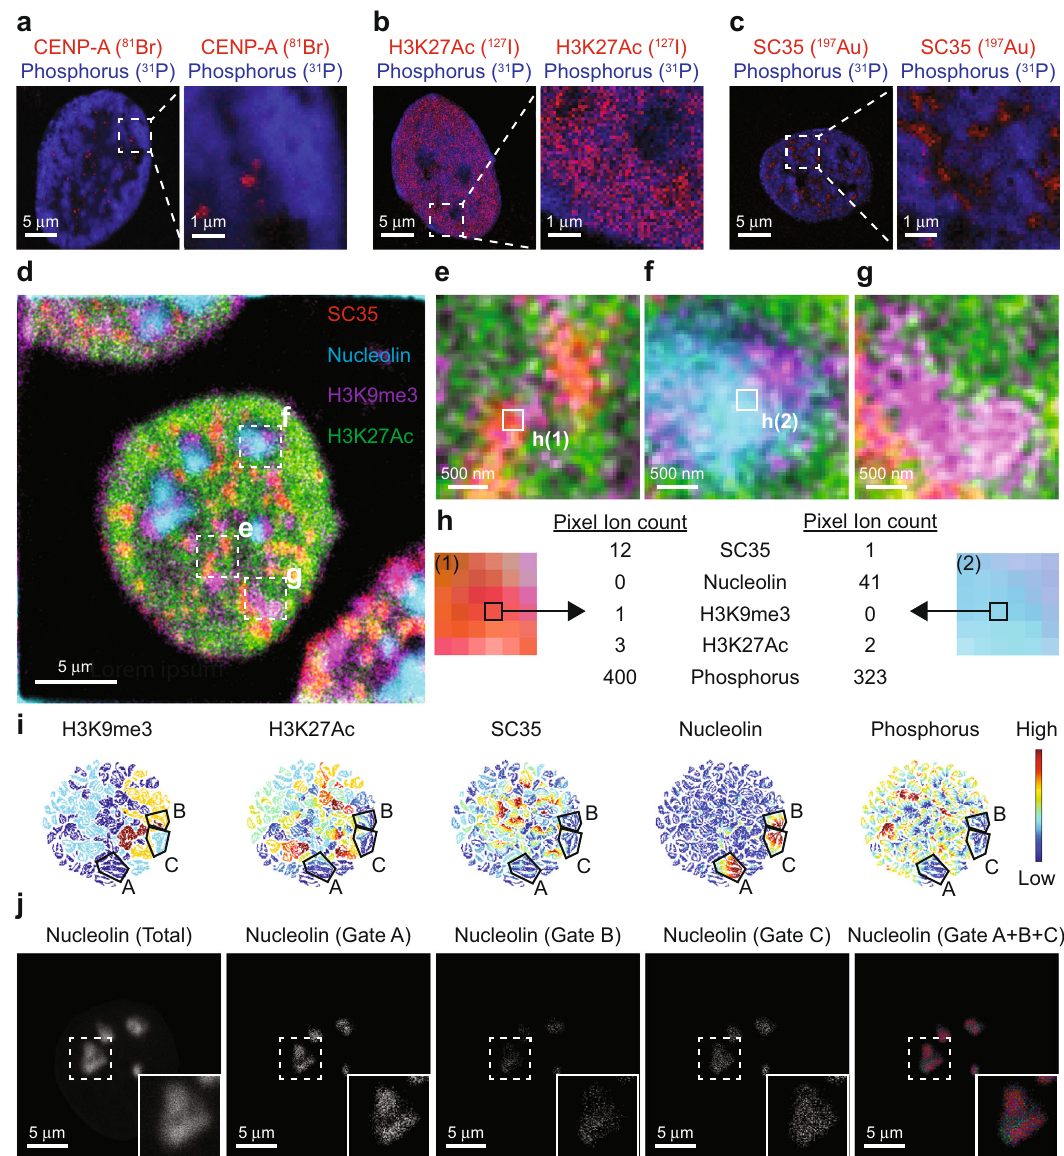
Fig. 2 Multiparametric HD-MIBI using MoC-Abs identi fi es unique subcellular features. a – c (Left) Representative HD-MIBI images of a HeLa cell stained with a anti-CENP-A- 81 Br/Cy3, b anti-H3K27Ac- 127 Ir/Cy5, and c anti-SC35-biotin recognized by streptavidin- 197 Au/FITC. Overlay of ion images for MoC- Ab (red) and phosphorus ( 31 P; blue). (Right) A digital zoom of boxed area in the original image to show speci fi city of MoC-Ab signal. All images consist of the sums of 10 consecutive planes. n = 3. d Composite HD-MIBI image of nucleolin (cyan), H3K9me3 (magenta), H3K27Ac (green), and SC35 (red) in a HeLa cell. Cells were stained with anti-nucleolin- 19 F/FITC, anti-H3K9me3- 81 Br/Cy3, anti-H3K27Ac- 127 Ir/Cy5, and anti-SC35-biotin (recognized by streptavidin- 197 Au/FITC). The image consists of the sum of 10 consecutive planes. n = 3. e – g Multiple enlarged images from boxed regions in panel ( d ) showing e a nuclear speckle, f a nucleolus, and g heterochromatin. h The largest nucleus in panel ( d ) was masked using the phosphorus signal. The ion counts for each acquired marker (nucleolin, 19 F; DNA, 31 P; H3K9me3, 81 Br; H3K27Ac, 127 I; and SC35, 197 Au) were extracted. i t-SNE maps of the nucleus in the center of the image shown in panel ( d ) were created using the ion counts for each of the 84,836 pixels from the mask described in ( h ). The ion count for each marker in each pixel was min – max normalized to scale the range to [0, 1]. Each point represents a pixel. Pixels grouped in distinct regions based on the expression of each marker. The color in each map represents the intensity of the indicated marker in each pixel. The areas marked A – C indicate three distinct groups of nucleolin-positive pixels identi fi ed manually in the nucleolin map. j Grouped pixels from the unsupervised viSNE map are differentially distributed in space as shown in HD-MIBI images of (1) total nucleolin ( 19 F) from the HeLa cell shown in panel ( d ), (2) 19 F signals from pixels within gate A, (3) gate B, (4) gate C, and (5) overlay of 19 F signals from gates A (red), B (green), and C cells with phalloidin conjugated to ATTO514, a fl uorophore components 29 . We also validated detection of SC35, a protein enriched in nuclear speckles, using anti-SC35-biotin with containing six 19 F atoms (Fig. S11A). The distribution of actin fi laments observed in HeLa cells labeled with this reagent was streptavidin-labeled 1.4 nm gold nanoparticles (streptavidin- 197 Au/FITC) by HD-MIBI (Fig. 2c and Fig. S12). We further comparable in confocal microscopy and HD-MIBI images (Fig. S11B, C). Nuclear speckles are nuclear domains containing validated this tool by labeling nucleoli (anti-NPM1-biotin recognized by streptavidin- 197 Au/FITC) (Fig. S13). Collectively, inter-chromatin material enriched in pre-mRNA splicing